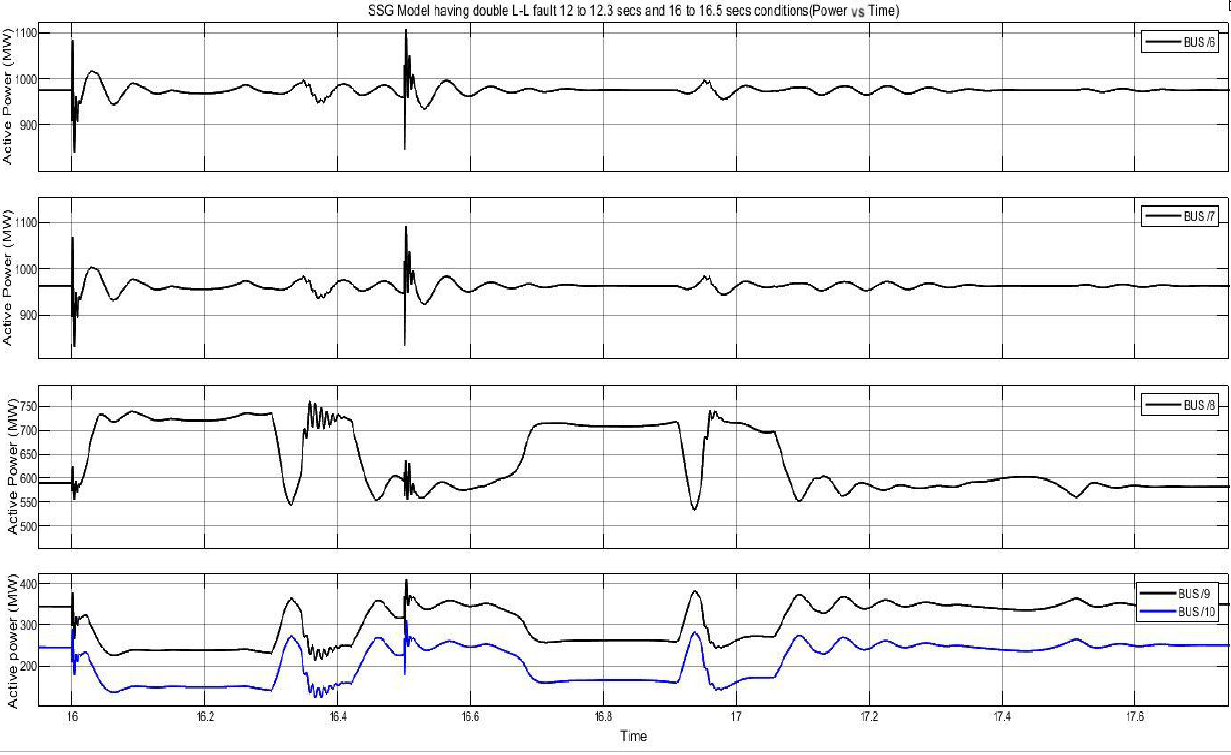
Figure 30. Transient stability being provided by UPFC after multiple double faults L-L introduced 16 to 16.5 s (Bus 6 to Bus 10).